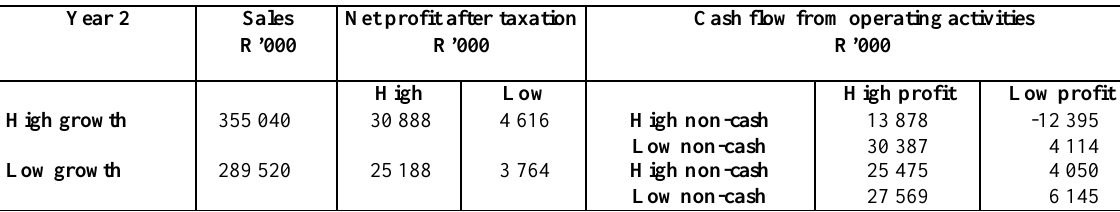
Table 1: Calculation of cash flow from operating activities per